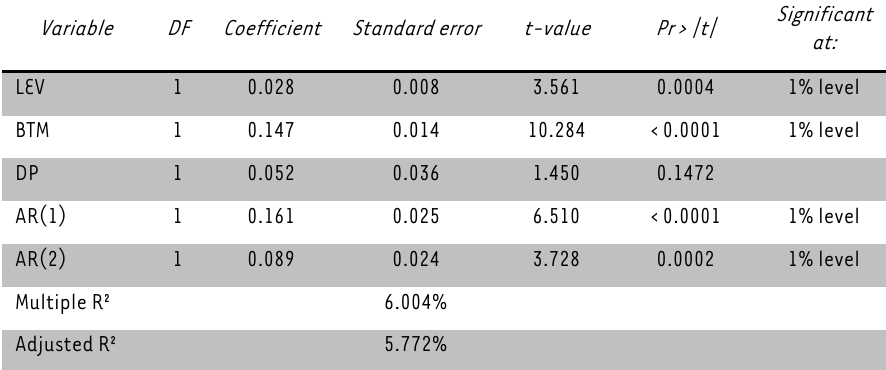
TABLE 5: Regression model with AR